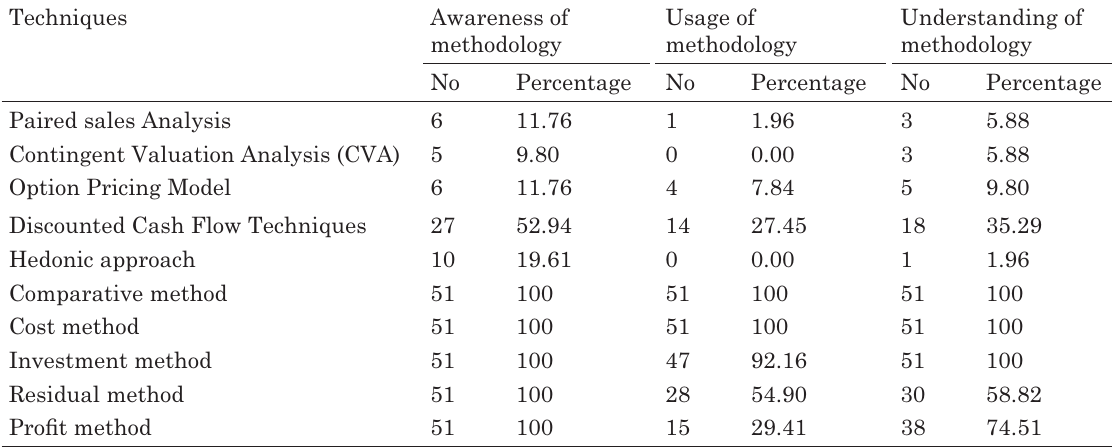
Table 3. Awareness of the specifi c techniques of valuing contaminated